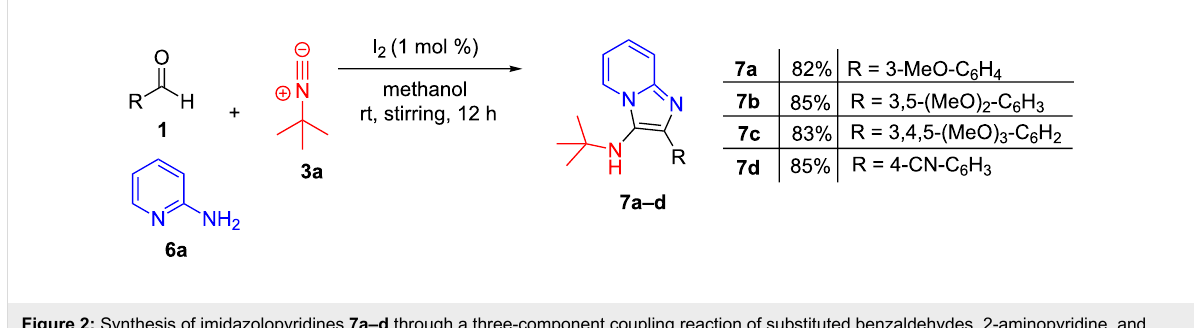
Figure 2: Synthesis of imidazolopyridines 7a–d through a three-component coupling reaction of substituted benzaldehydes, 2-aminopyridine, and tert -butyl isocyanide using 1 mol % iodine as catalyst.